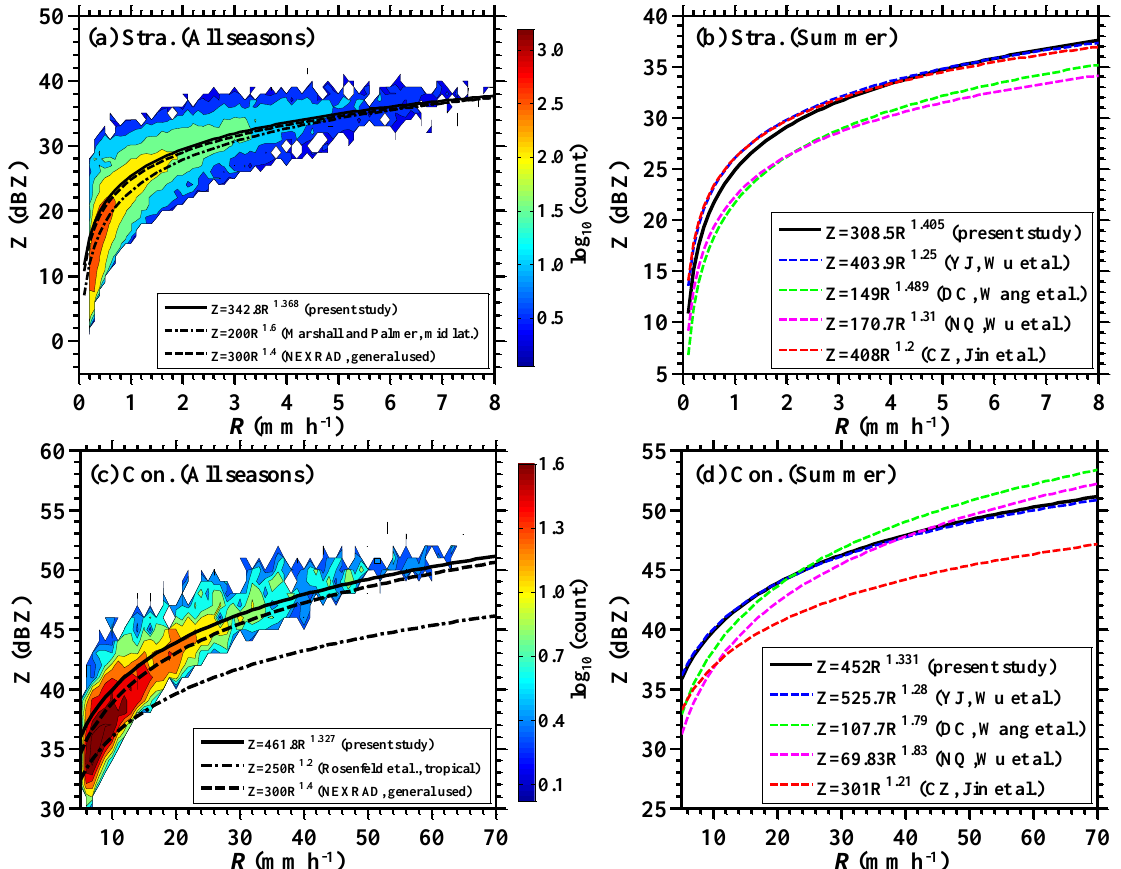
Figure 8. Z–R scatterplots and fitting results for annual ( a , c ) and summer ( b , d ) for stratiform (first row) and convective (second row) rains. The Z – R relationships reported in other studies are also plotted. YJ, NQ, DC, and CZ denote Yangjiang (located in southern China, Wu et al., 2017 [52]), Naqu (located in the mid-Tibetan Plateau, Wu et al., 2017 [52]), Daocheng (located in the eastern Tibetan Plateau, Wang et al., 2020 [13]), and Chuzhou (located in the east China, Jin et al., 2015 [35]). The scenario for convective rain is depicted in Figure 8c,d. It can be seen from Figure 8c that there is an inconsistency between the relationship that we built in this study ( Z = 461.8 R 1.327 ) and the NEXRAD operational relationship ( Z = 300 R 1.4 ), although the trends are identical. The tropical used relationship ( Z = 250 R 1.2 ) [50] performs worst in our study region. For summer, the intercomparison of four existing Z–R relationships with that of our study ( Z = 452 R 1.331 ) in CD shows that the Z–R relationship in YJ (southern China, Z = 301 R 1.21 ) [52] has the most similar pattern and the Z–R relationships in East China has the most different